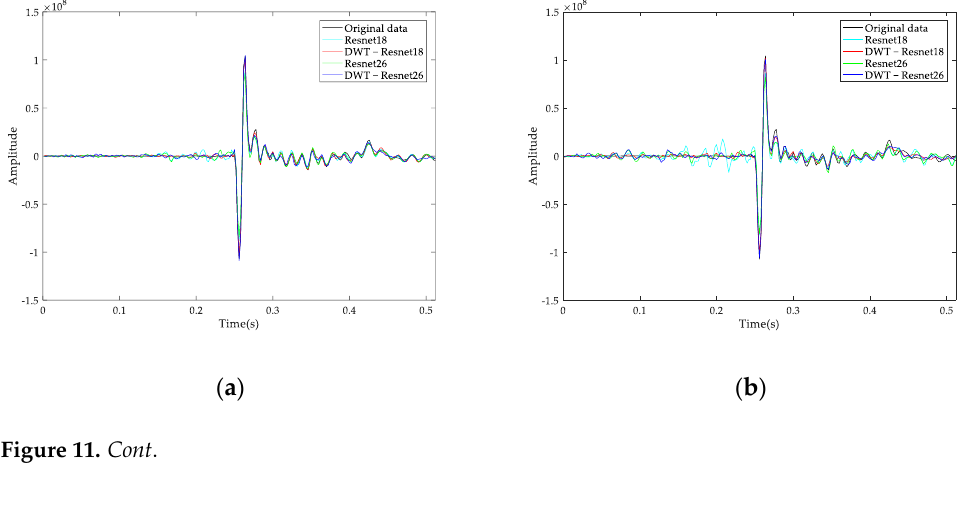
Figure 10. Comparison of denoising results using Resnet18, Resnet26, DWT−Resnet18, DWT−Resnet26 w ith different input SNRs.